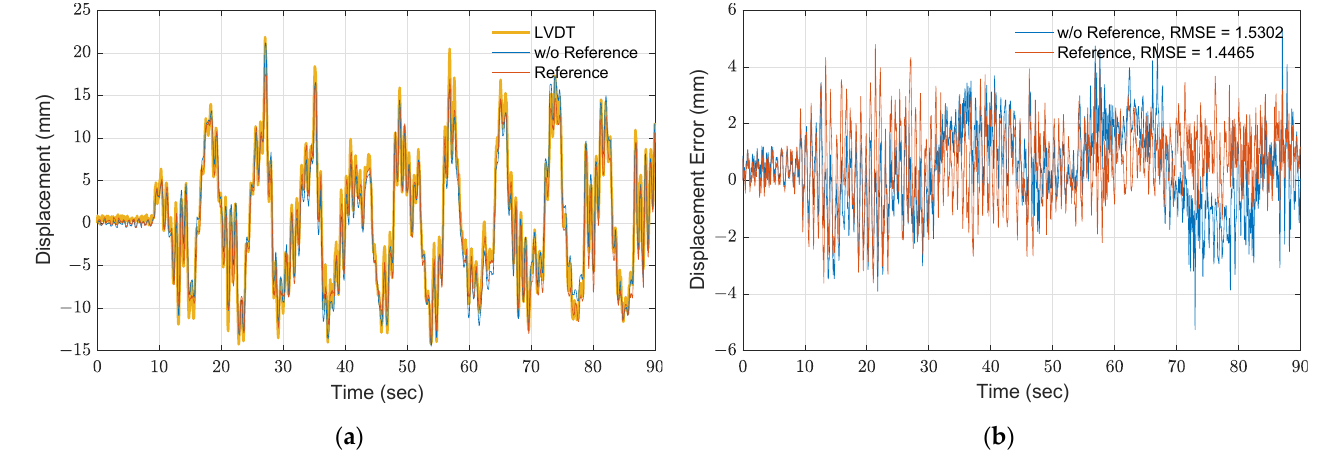
Figure 4. Comparison of different optical flow estimation approaches: ( a ) time history; ( b ) errors.